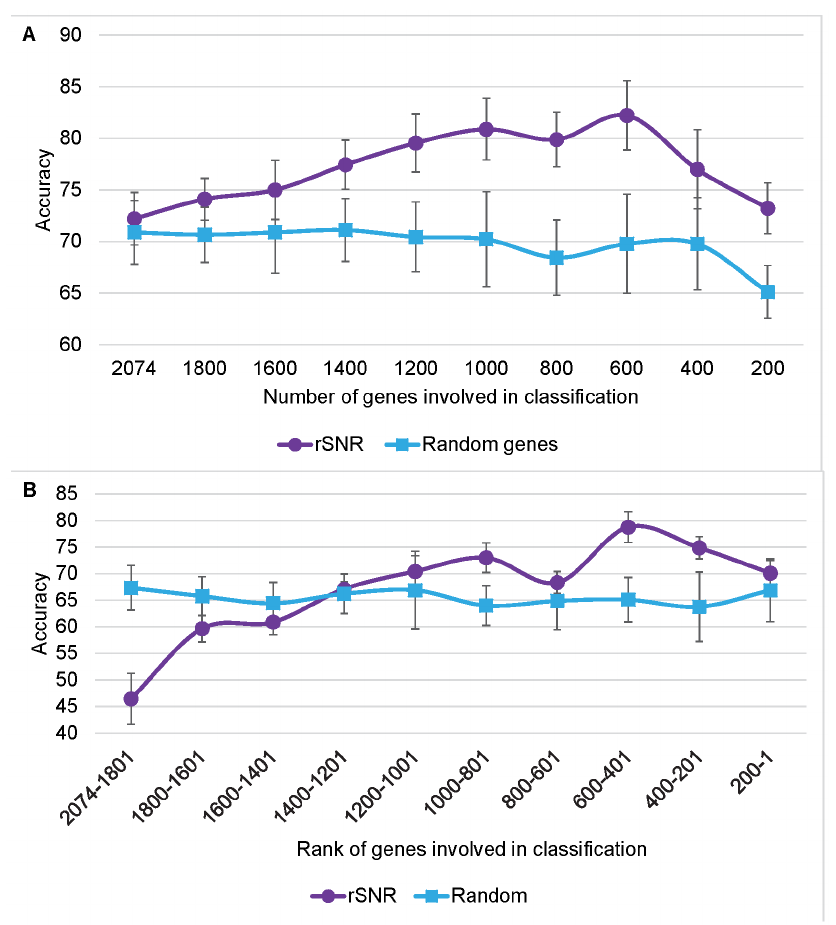
Figure 5. Evaluation of the effect of the rSNR-based rank on the classification of experiments from the AtGenExpress dataset. A) Accuracy was calculated based on gene sets of uniformly decreasing size, selected based on rSNR ranking. B) Accuracy was calculated based on gene sets belonging to different rSNR-based rank sections. Error bars indicate 1 standard deviation away from the mean.